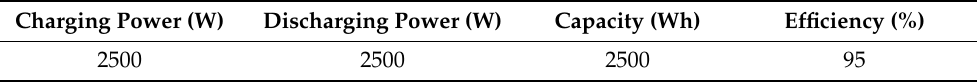
Table 3. Battery characteristics